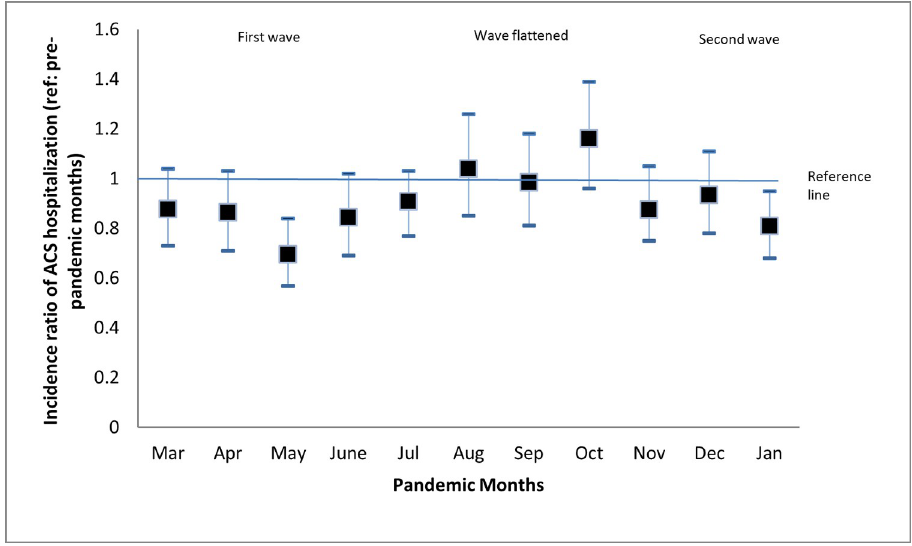
Fig 2. Incidence ratios of ACS hospitalization between pre-pandemic vs. pandemic months.